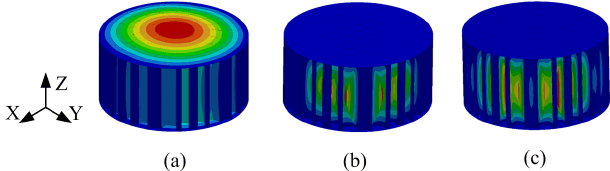
Figure 15. Simulated mode shapes for the C 2 -type panel: ( a ) mode at 5288 Hz; ( b ) mode at 6824 Hz; ( c ) mode at 6829 Hz.